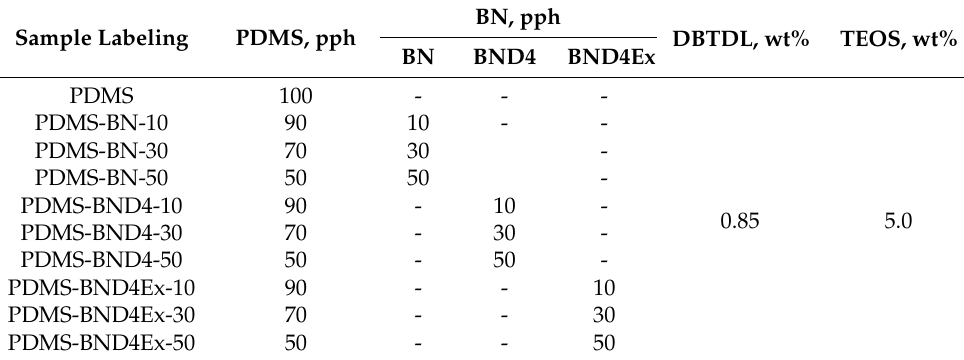
Table 1. Feed reagents amounts to obtain the series of